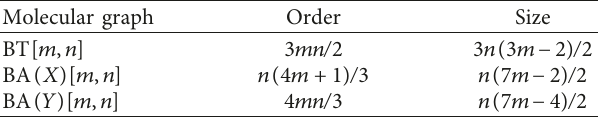
Table 1: The order and size of boron nanotubes. Molecular